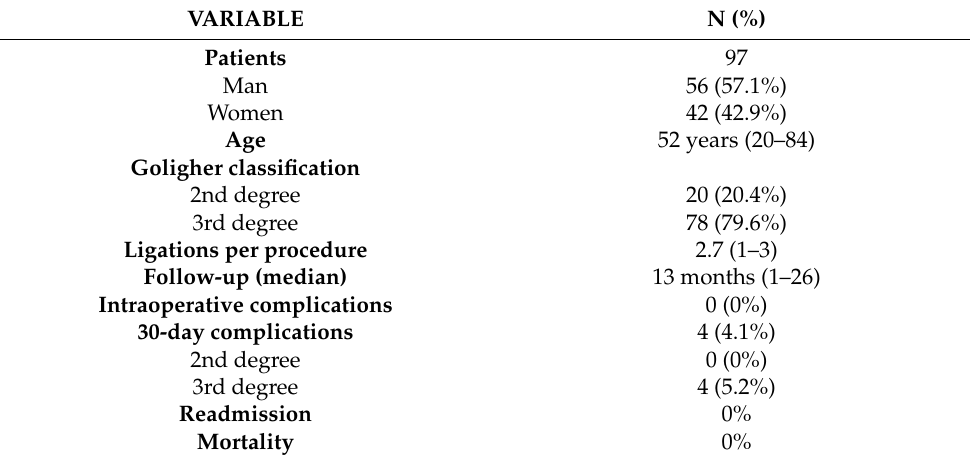
Table 1. Demographic and postoperative outcomes of the patients included in the study. Age and ligations per procedure are expressed as a mean with therange between parentheses. Median is expressed as a median.